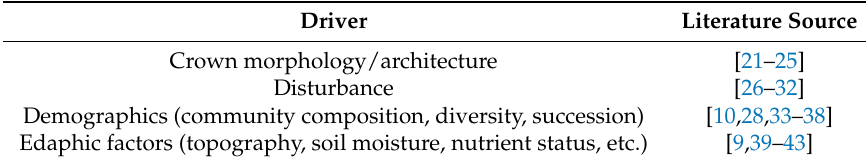
Table 1. Examples of drivers and potential sources of spatial variation in canopy structure